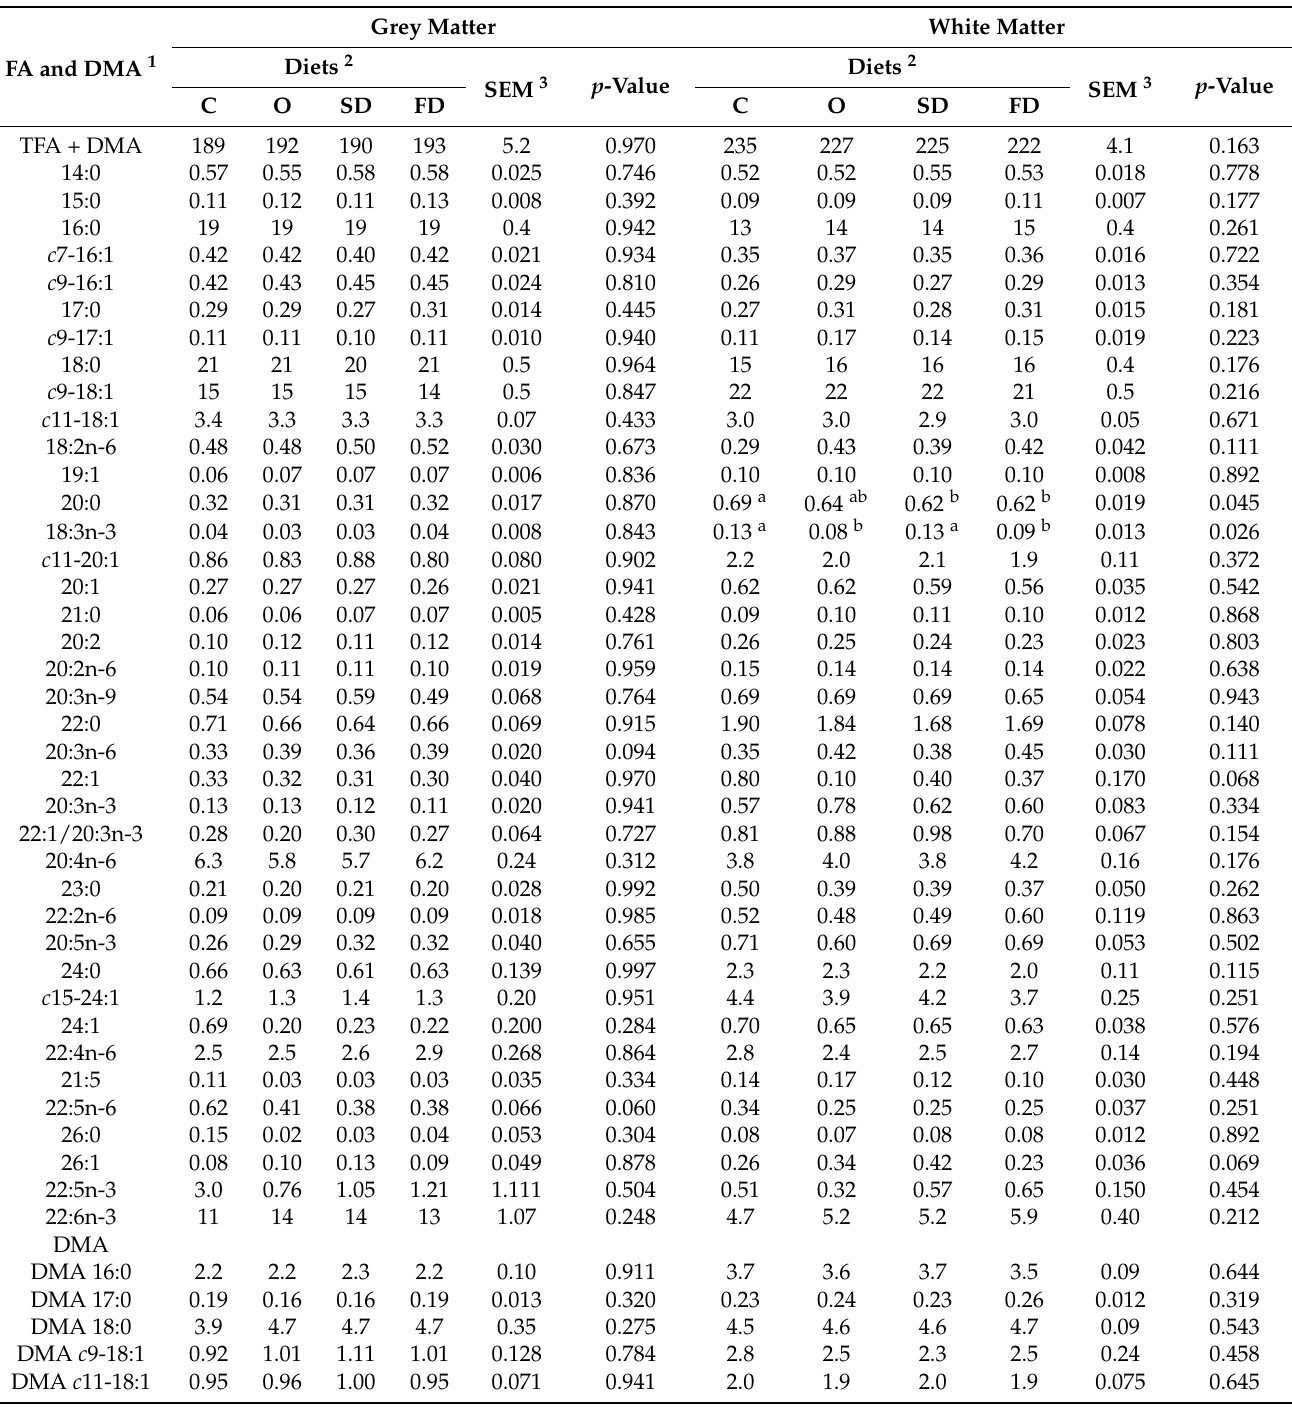
Table 3. Total fatty acid (TFA) and dimethyl acetal (DMA) content (mg/g DM) and composition (% TFA + DMA) of the grey matter and white matter of